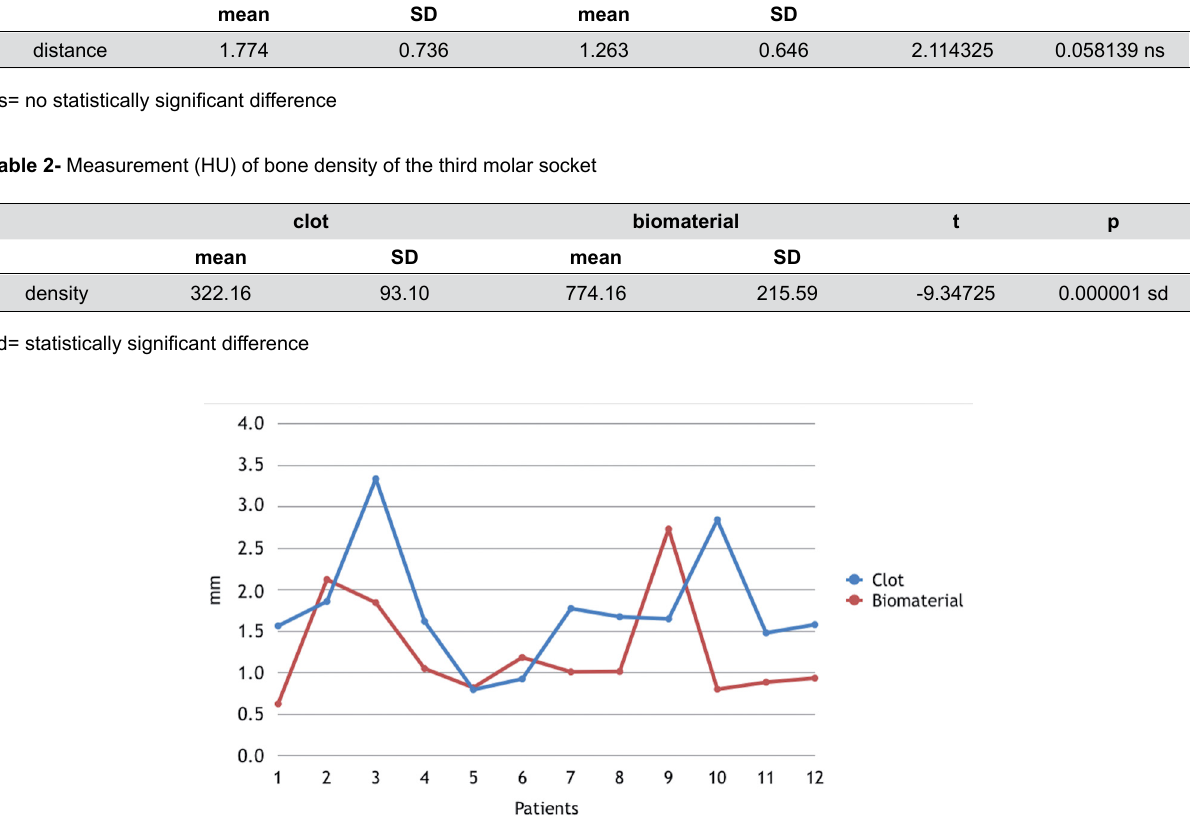
Table 1- Measurement (mm) of the distance from the crest of alveolar bone to the cementoenamel junction (CEJ) in the distal second molars clot biomaterial